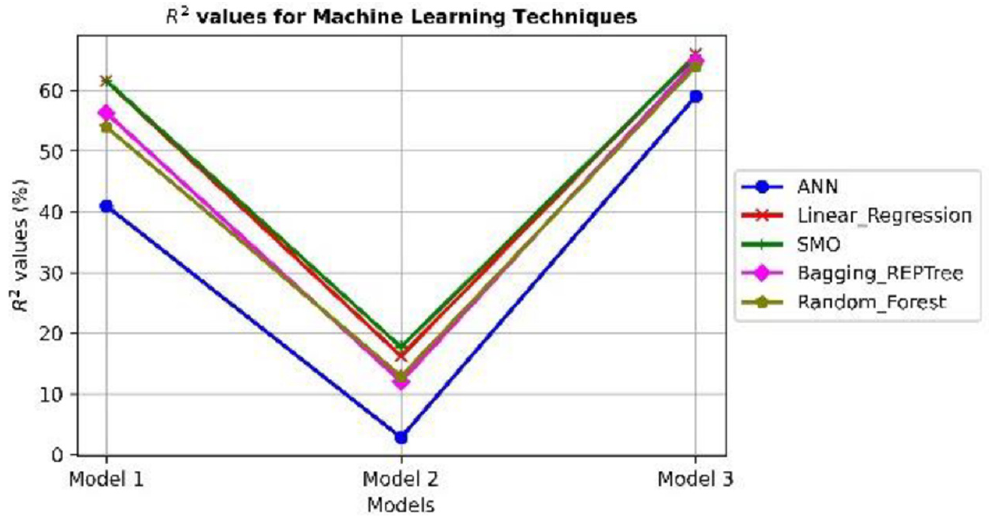
Figure 3. The results of (R 2 ) using ML techniques on Social Isolation dataset.